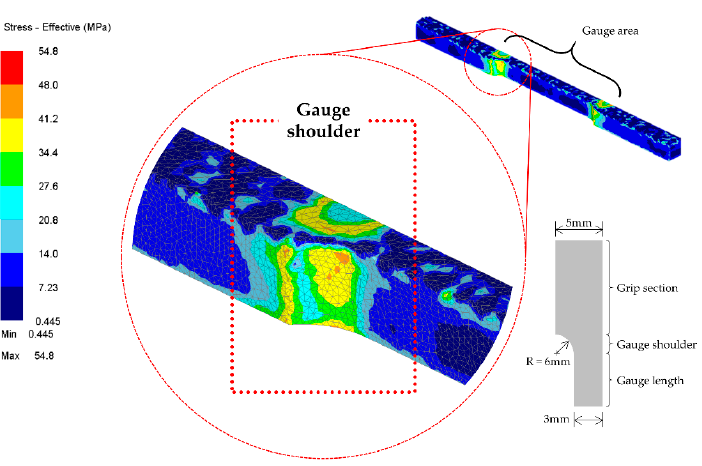
Figure 7. Higher stress recorded at the gauge shoulder.